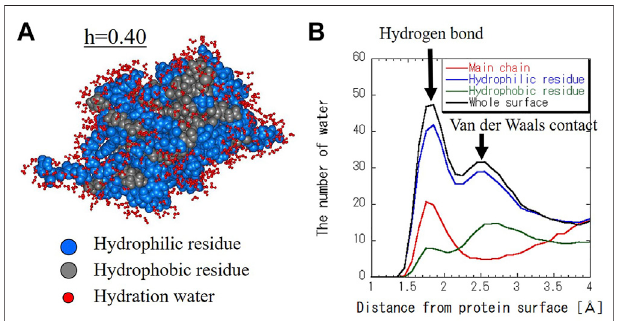
FIGURE 2 | (A) Structure of hydrated SNase at h (cid:1) 0.40 (g water/g protein). Hydrophilic and hydrophobic residues are blue and gray balls, respectively. Hydration water molecules whose oxygen atom is within 4 Å from the protein surface are shown in red. (B) The number of hydration water as a function of distance from the protein surface for the main chain, hydrophilic and hydrophobic residues, and whole surface. The distance between the protein surface and the water molecules was calculated as the distance between the atoms that make up the protein and the oxygen atoms of the water molecules.